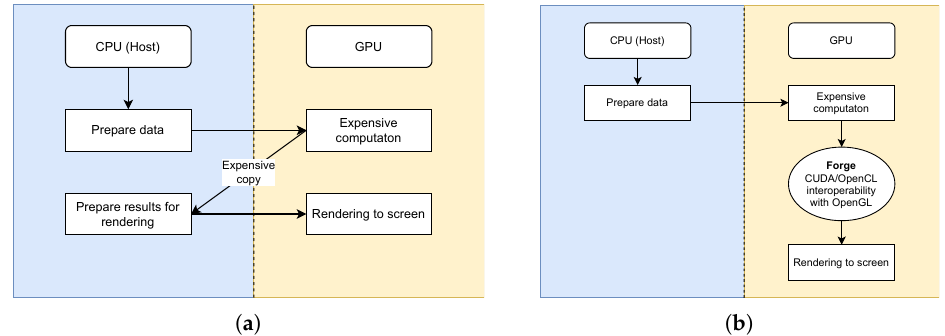
Figure 2. Differences between CPU-bound visualization with expensive copying bottleneck and high- performance GPU-bound visualization keeping full speeds of high-bandwidth of PCIe interface. ( a ) High- performance expensive visualization pipeline; ( b ) High-performance OpenGL visualization pipeline.